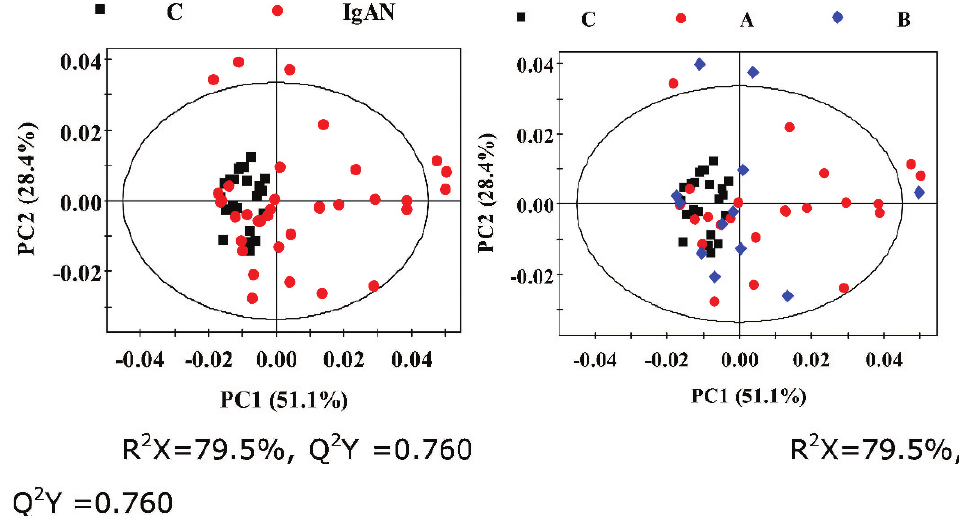
N ). Right panel: C: control group, black box ( & ); A: IgAN-A group, red dot (